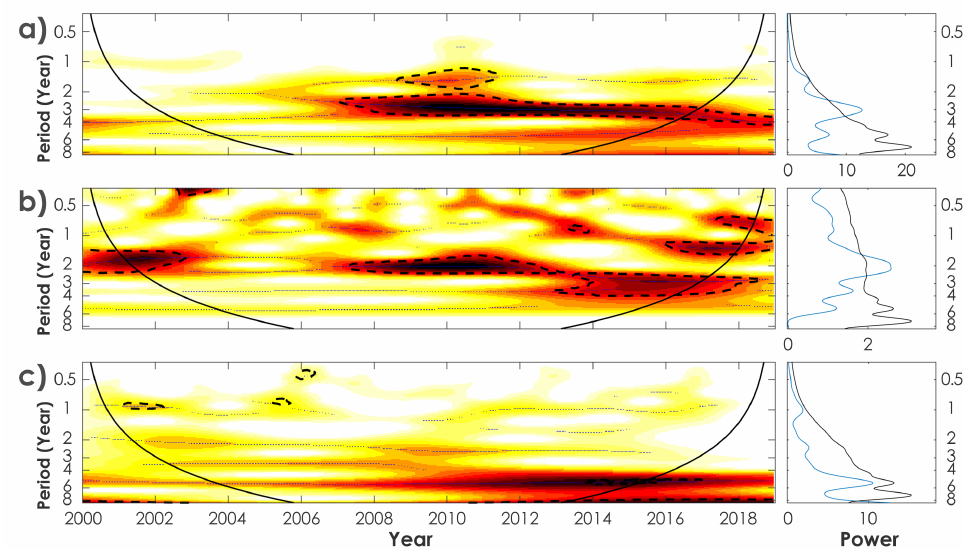
Figure 3. Wavelet analysis of climatic indices monthly data between 2000 and 2018. ( a ) MEI, ( b ) PDO and ( c ) SAM. The left panels show local wavelet power spectrum. The color code for power values is from white (low power values) to dark red (high power values). The dot-black lines indicate the 95% significant areas obtained by adapted bootstrapping [57] and the cone of influence (bold-black lines) indicates the wavelet domain where computations are not influenced by edge effects (see [56]). The right panels show the global wavelet power spectrum for the period examined (2000–2018) with the black line showing a 95% confidence interval obtained by adaptive bootstrapping (note that they have different scale for better visualization).